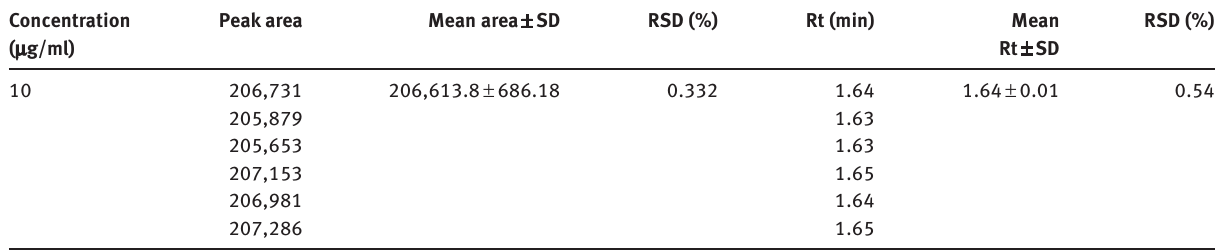
Table 2: Selectivity of the proposed HPLC method (n = 6).